Question: Give a one-sentence summary of this figure.
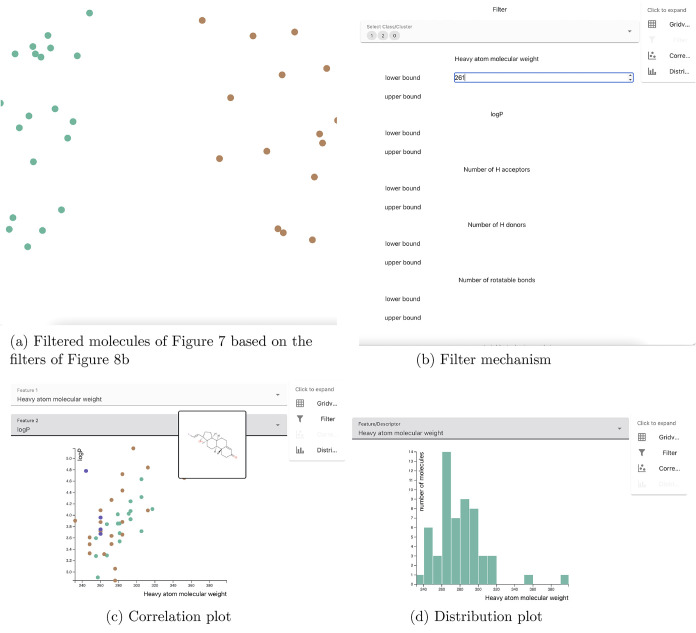
Answer: Components of the PegaPlus web server. (a) and (b) display the filter mechanism. There are currently six filters: heavy atom molecular weight, log P , number of hydrogen bond acceptors, number of hydrogen bond donors, and number of rotatable bonds. (c, d) show the correlation and distribution plots, respectively. The same properties can be set as in the filter mechanism.